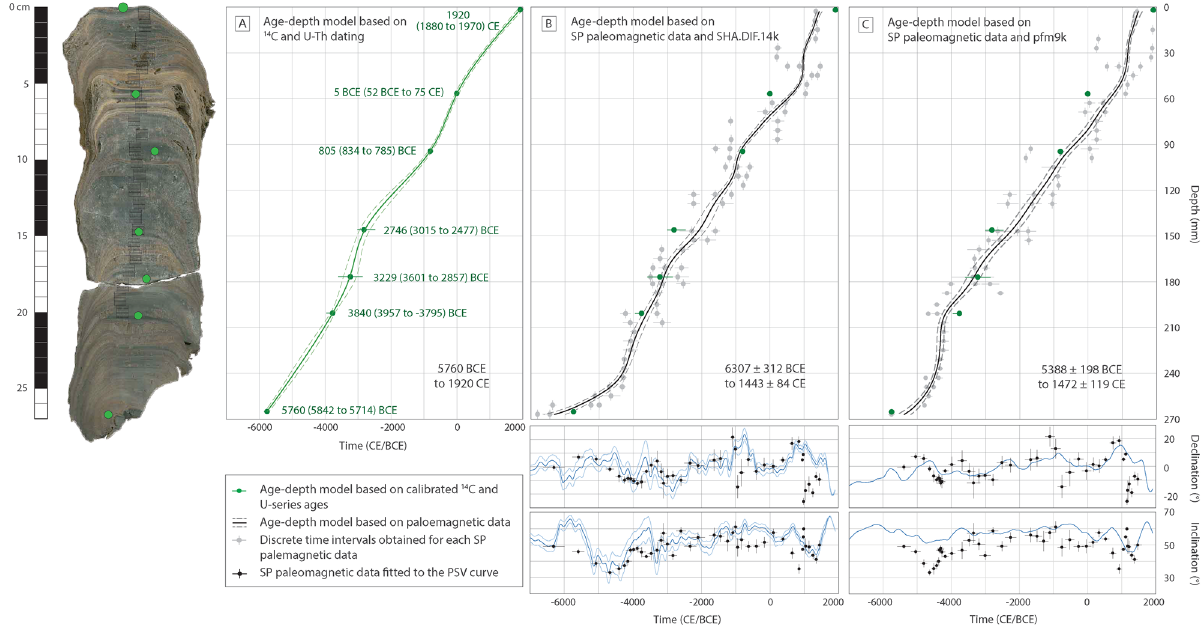
Figure 4. Age-depth models of the Soprador do Carvalho stalagmite. ( A ) Age-depth model based on calibrated 14 C and U–Th anchor ages. ( B ) Age-depth model ( above ) obtained after fitting its paleomagnetic data to the magnetic declination and inclination of the PSV curve of the SHA.DIF.14k model (below). ( C ) Equal to ( B ) but using the PSV curve of the pfm9k model. Grey points on the upper panel of ( B,C ) correspond to the different dating intervals given by using the archaeo_dating tool (see Table S1 of the Supplementary Information). Vertical error corresponds to half of the specimen thickness (± 3 mm), while horizontal error corresponds to the 95% confidence interval of dating according to the archaeo_dating outputs. Black points on the lower panels in ( B,C ) correspond to the paleomagnetic directions calculated for each SP specimen at the ages estimated by the corresponding age model (the vertical error is the maximum angular deviation associated with the characteristic remanent magnetization (ChRM), and the horizontal error correspond to the age errors given by the paleomagnetic age models). Calibrated 14 C and U–Th dating (green points) are illustrated in ( B,C ) for comparison. Maximum (bottom of the stalagmite) and minimum (top) ages for each age model are indicated by the black text. All age models are represented with error bands at 95% of